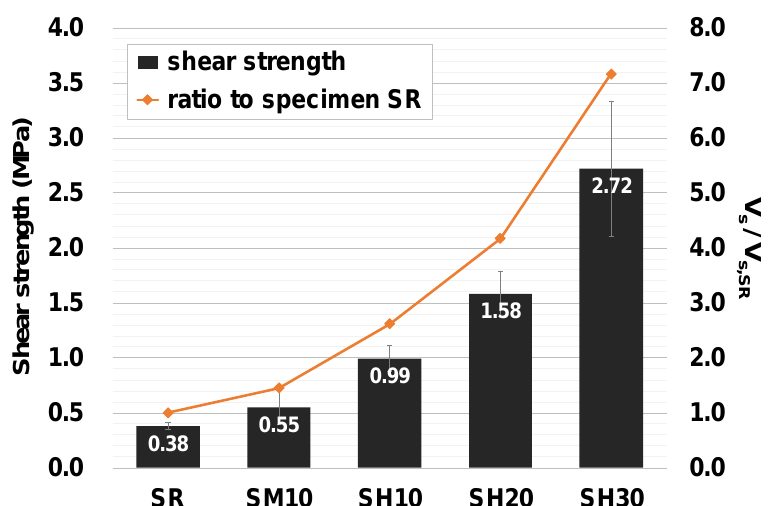
Figure 7. Results of initial shear strength of masonry prism.